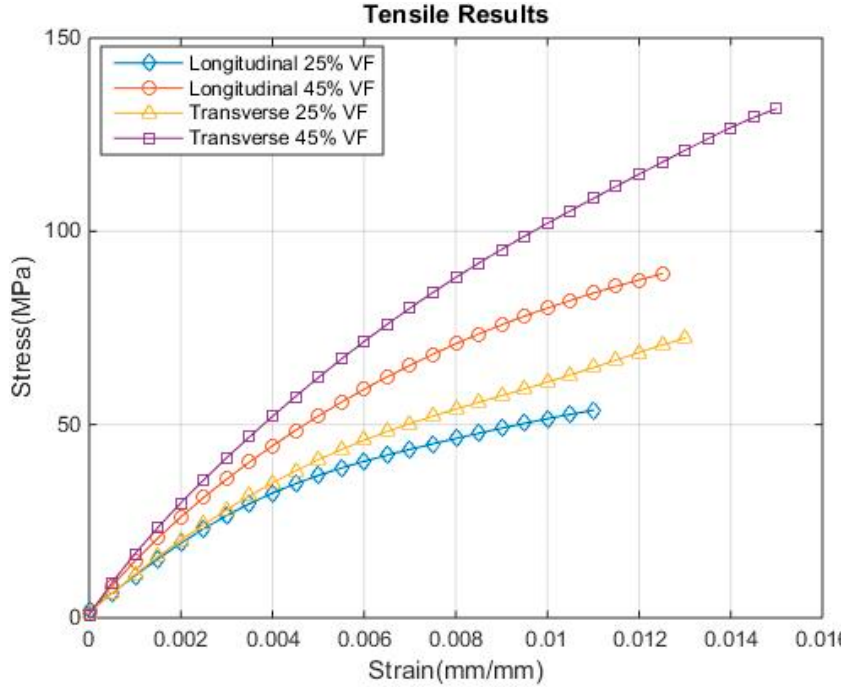
Figure 5. Uniaxial tensile stress–strain curves for the longitudinal and transverse directions.